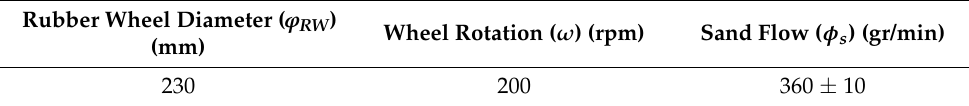
Figure 8. Morphology and dimension of abrasive sand. Table 2. General parameters of the wear test.